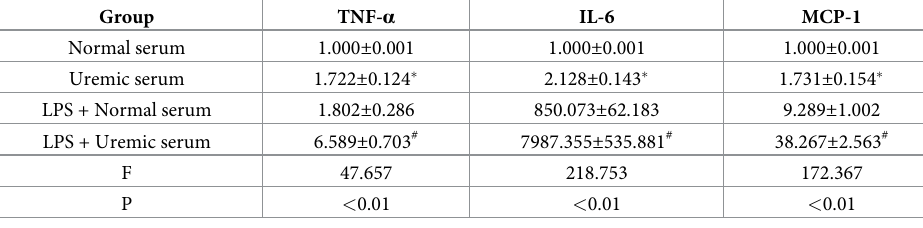
Table 2. Expression of M1 markers in peritoneal macrophages of rats in two groups after uremic serum